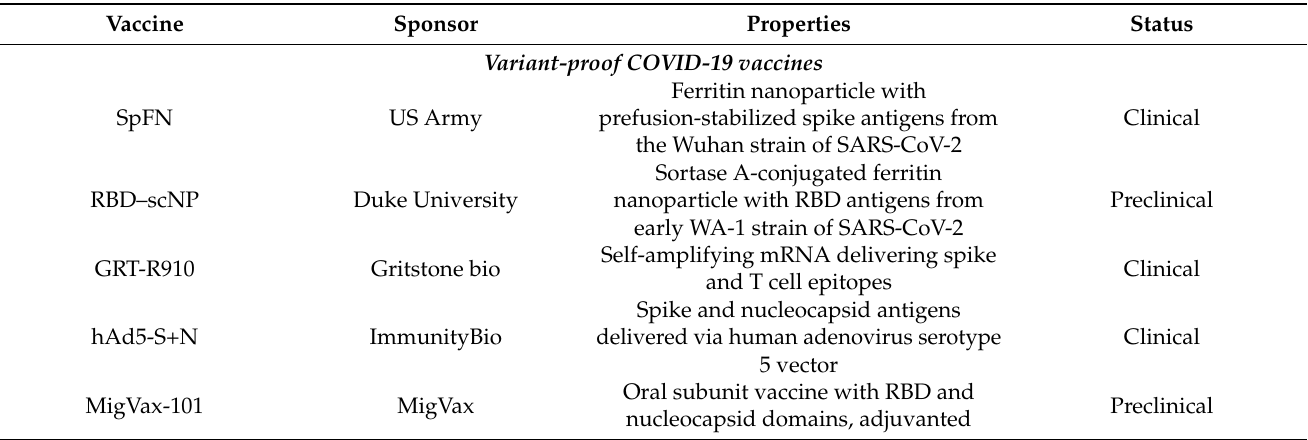
Table 1. Selected pan-coronavirus vaccines in